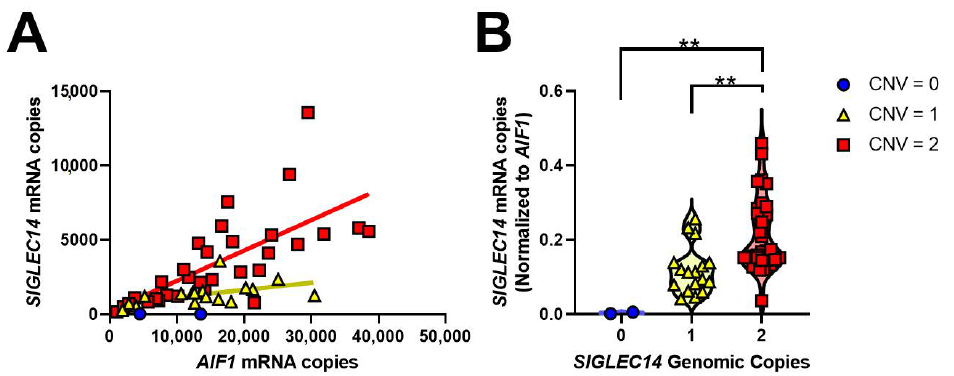
Figure 3. SIGLEC14 expression correlates with microglial gene AIF1 and SIGLEC14 CNV. ( A ) SIGLEC14 is expressed in microglia ( p < 0.0001, F 1,48 = 33.19, r 2 = 0.409). ( B ) SIGLEC14 CNV strongly correlates with SIGLEC14 gene expression ( p = 0.0002, F 2,47 = 10.679), Tukey’s post-hoc multiple comparisons test. ** p < 0.01. We do not have statistical power to compare expression with CNV > 2, given its low